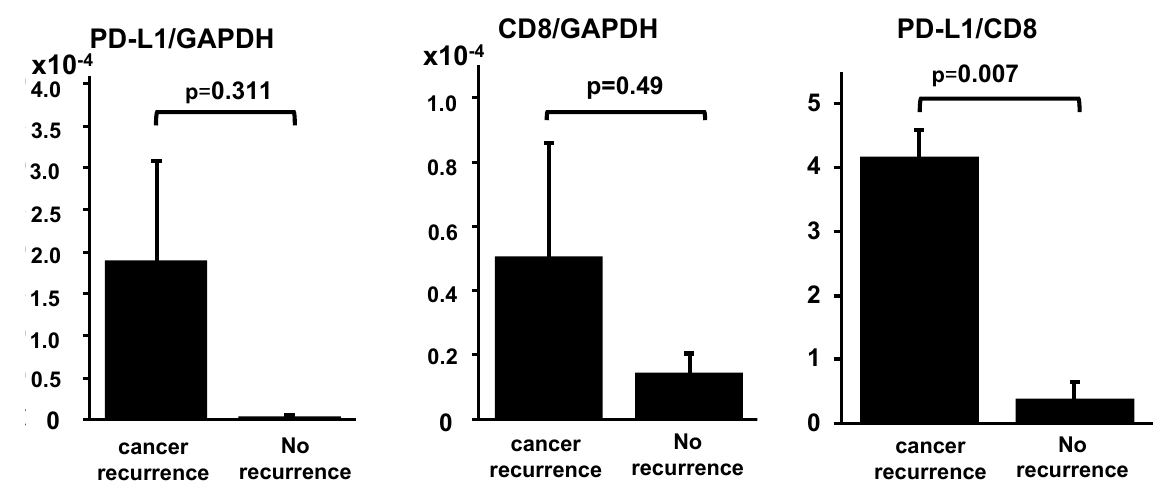
Figure 4. The results of tumor microenvironment analyses by quantitative polymerase chain reaction in both the cancer recurrence group and no recurrence group after salvage esophagectomy for local failure of definitive CRT. Each bar indicates a mean value with an error bar as the standard error. The ratio of PD-L1 mRNA to CD8B mRNA was statistically different between patients with good prognoses and with poor prognoses after the salvage surgeries ( p = 0.007). However, each expression level of PD-L1 and CD8B , adjusted by GAPDH mRNA, was not statistically different between these two groups.